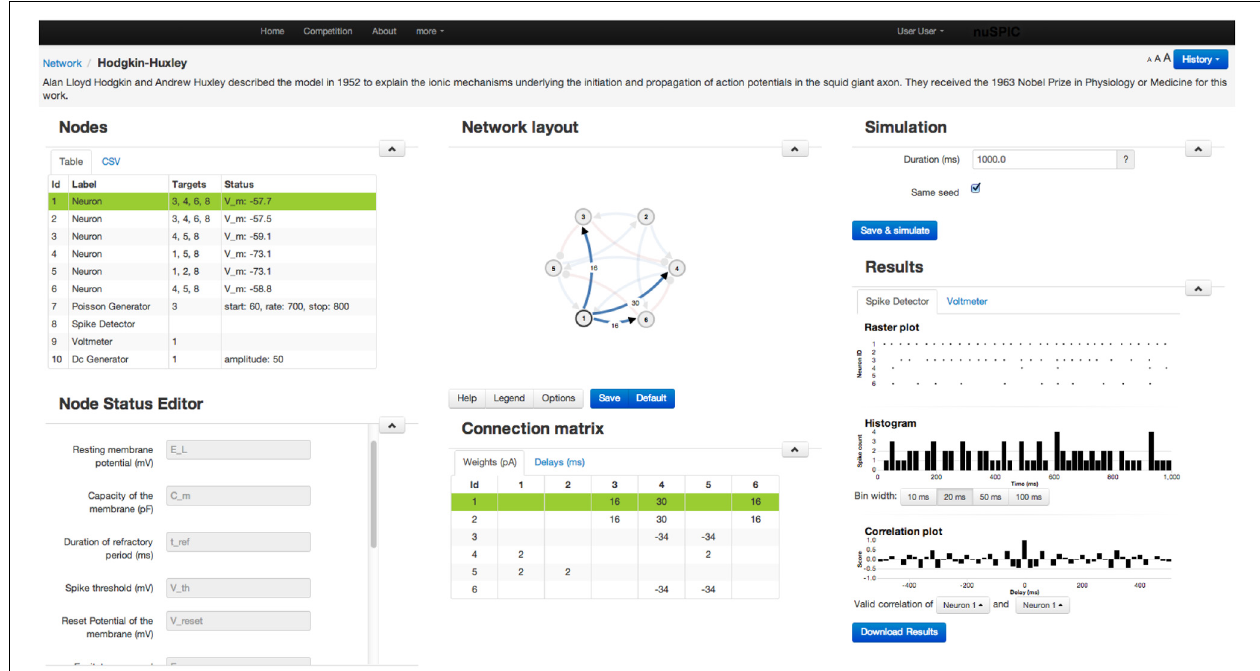
FIGURE 2 | A screenshot of the web-page showing the GUI for a Class I nu SPIC network. Various parameters of the neurons, synapses, recording and stimulating devices can be easily changed using the appropriate menus. Similarly, users can view the output